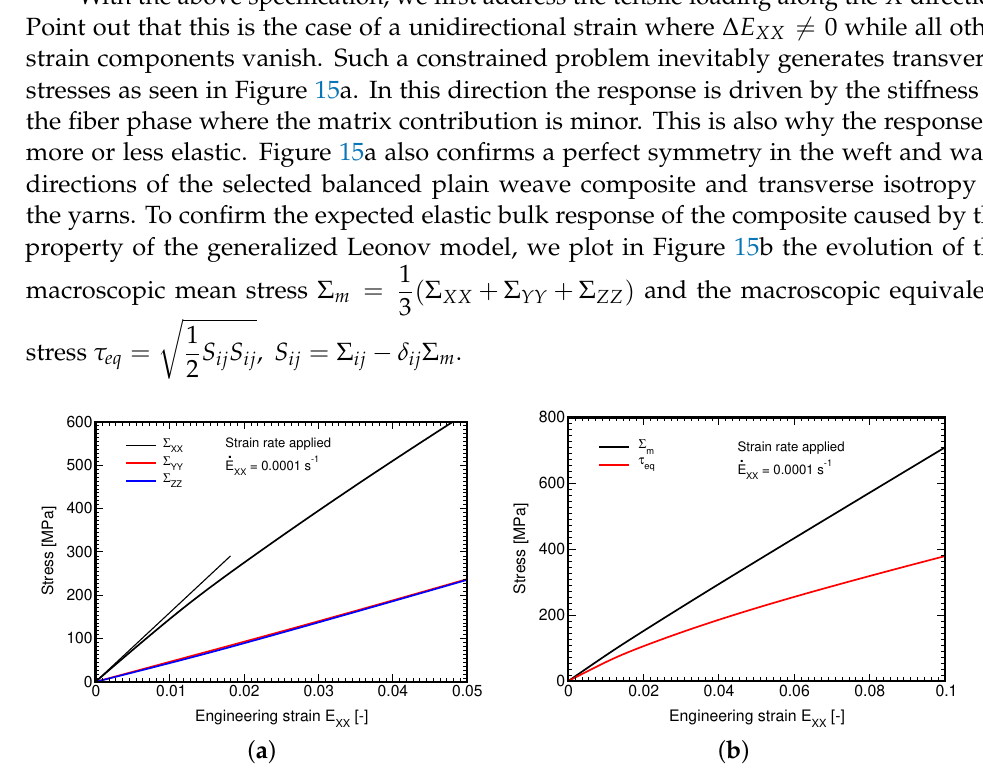
Figure 15. Plain weave composite loaded in tension by prescribed macroscopic strain rate ˙ E = 10 − 4 s − 1 : ( a ) macroscopic stress strain curves, ( b ) evolution of macroscopic mean stress XX Σ m and equivalent deviatoric stress τ eq .